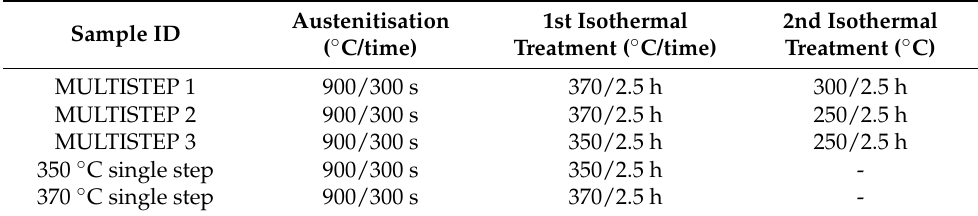
Figure 1. Bainitic multi-step heat treatment cycles after austenitisation at 900 °C for 5 min. Table 2. Resume of the performed heat treatment